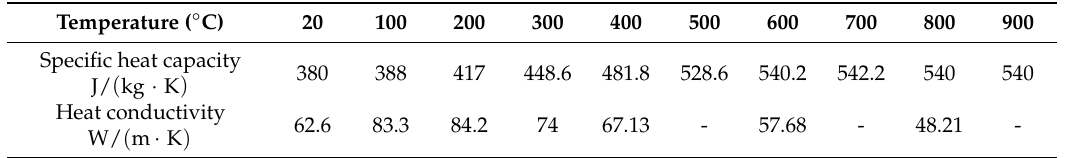
Table 7. Specific heat capacity and heat conductivity of dye material under 20 – 900 °C.